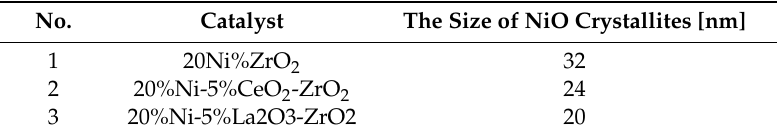
Table 2. Crystallite size of metallic nickel calculated from XRD measurements performed for spent Ni catalysts (after catalytic tests performed in the oxy-steam reforming of LNG process in the temperature range 400–700 °C, a molar ratio between reagents was used: C:H 2 O:O 2 = 1:2.7:0.35, the total gas flow was 51 cm 3 /min). No. Catalyst